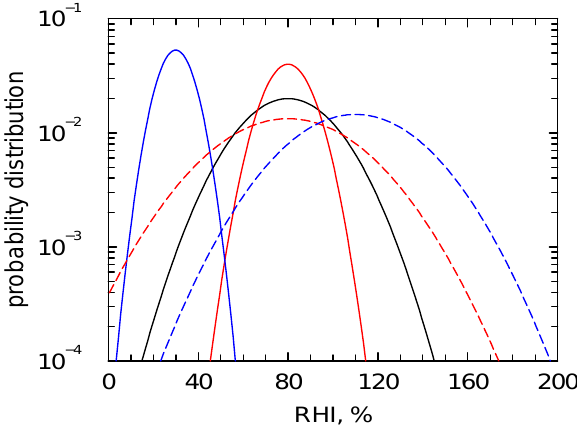
Fig. 3. Probability distributions of RHI obtained with normal dis- tributions of the H 2 O mixing ratio χ at constant temperature. The black and colored curves show analytical solutions. The baseline case (black curve) assumes T = 225 K, p = 250 hPa, χ o = 160 ppm, leading to RHI o = 80%, and σ w = 80 ppm. Red (blue) curves are obtained by changing σ w (RHI o ). See text for